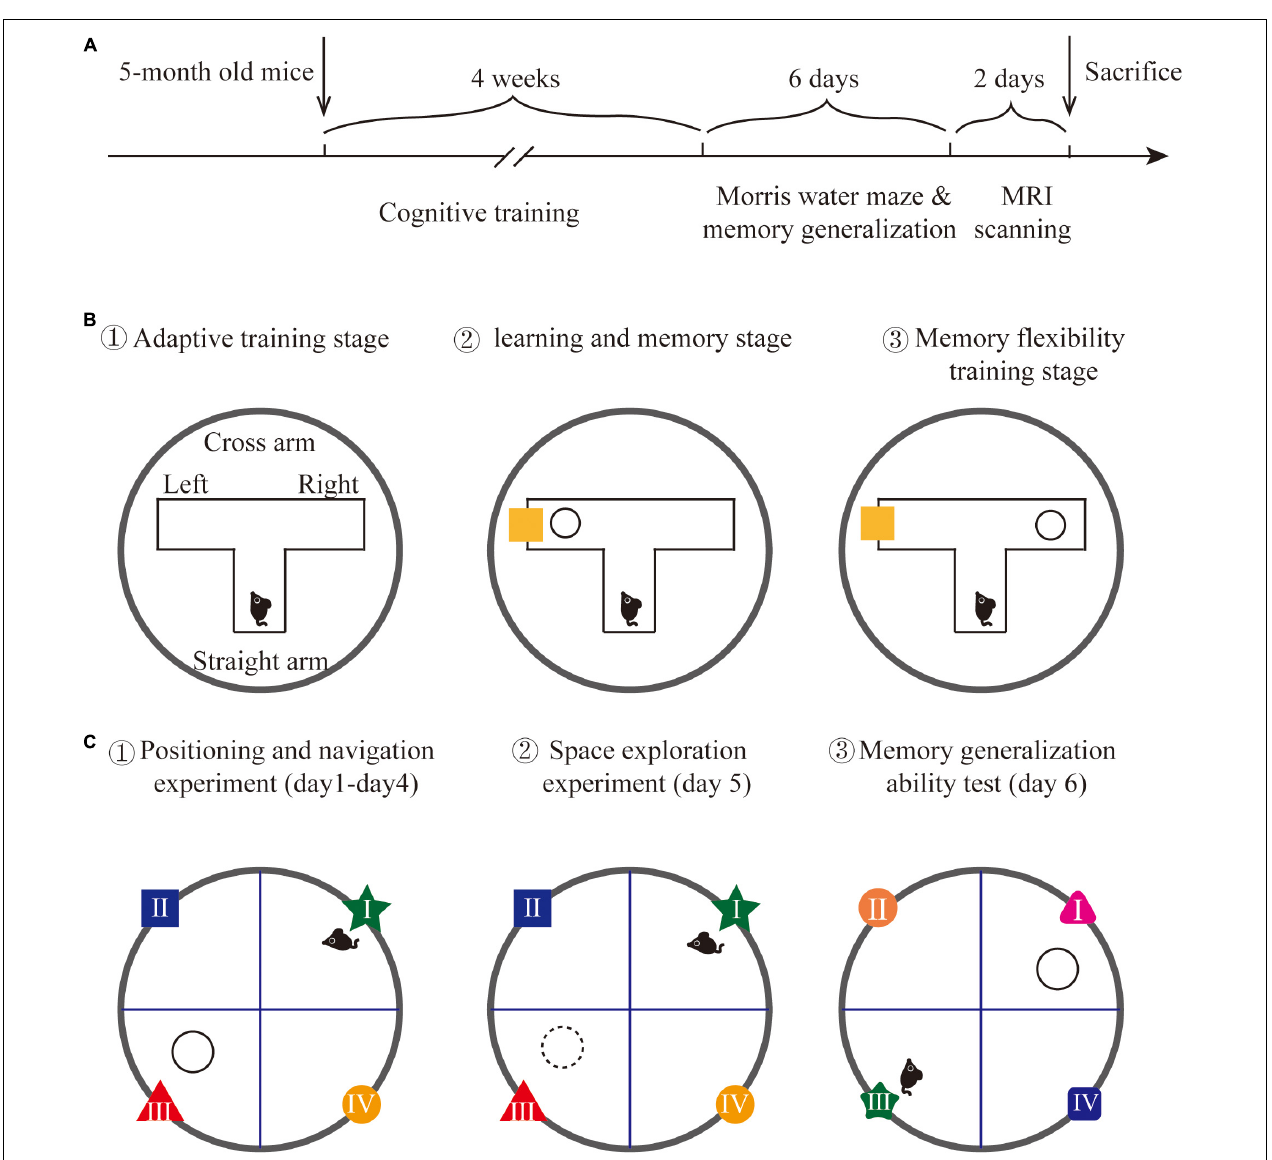
FIGURE 1 | Experimental design. (A) The detailed time line of this experiment. (B) The schematic graph of water T-maze cognitive training. (C) The schematic graph of the Morris water maze and memory generalization test.